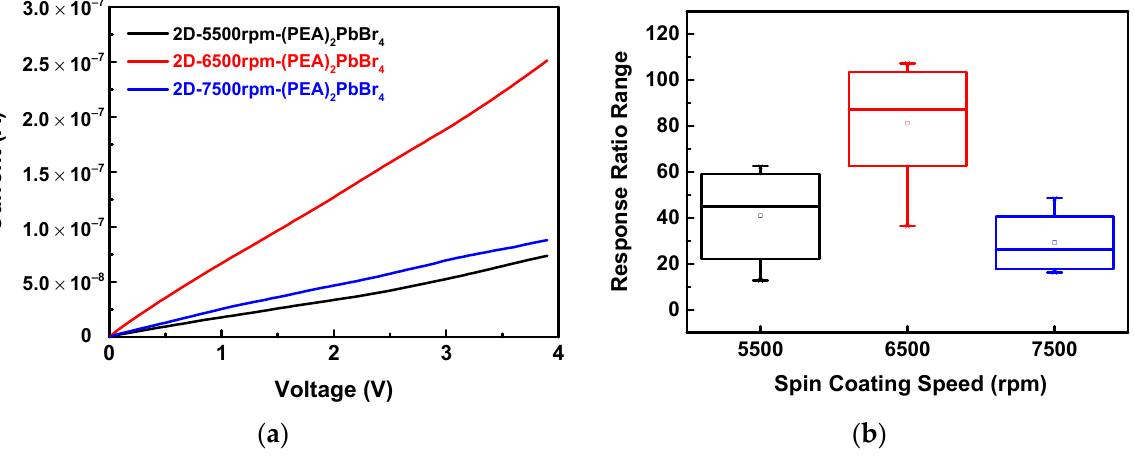
Figure 10. ( a ) Current–voltage (I–V) curves and ( b ) response ratio ranges of 2D-(PEA) 2 PbBr 4 films formed at different spin coating speeds to ethanol vapors.